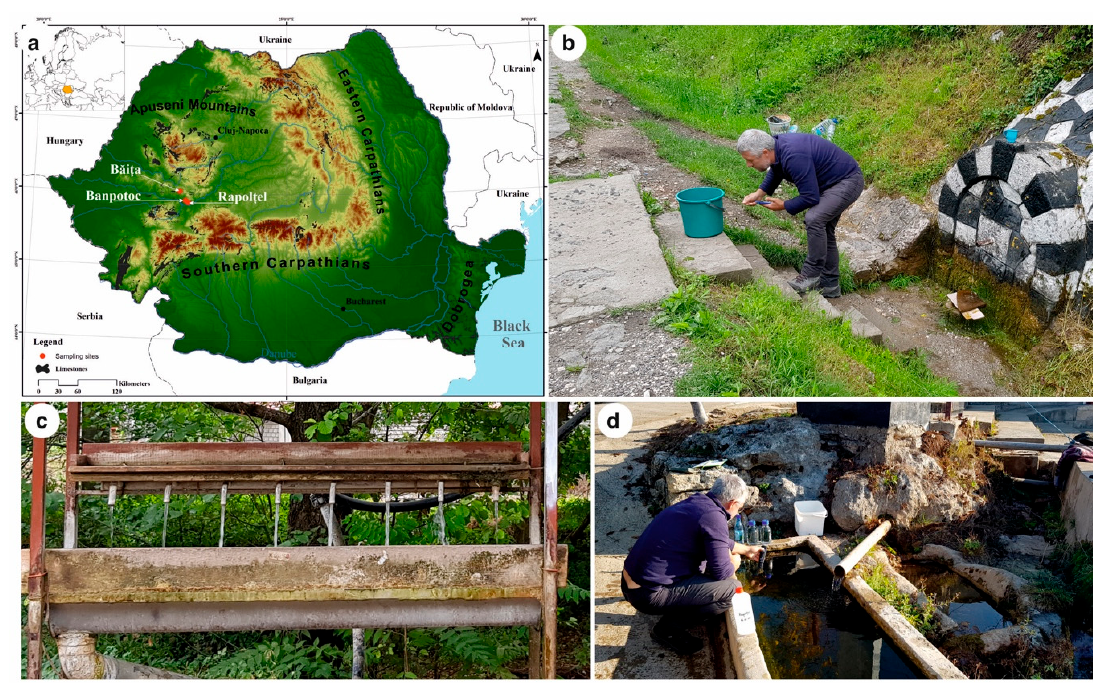
Figure 1. ( a ) The location of the three tested karstic springs in Romania and photos taken during the sampling campaign (( b ) = Baita, ( c ) = Banpotoc, ( d ) = Rapoltel). Table 1. The tested membrane filters for metabarcoding in karstic spring water. Membrane Membrane Code